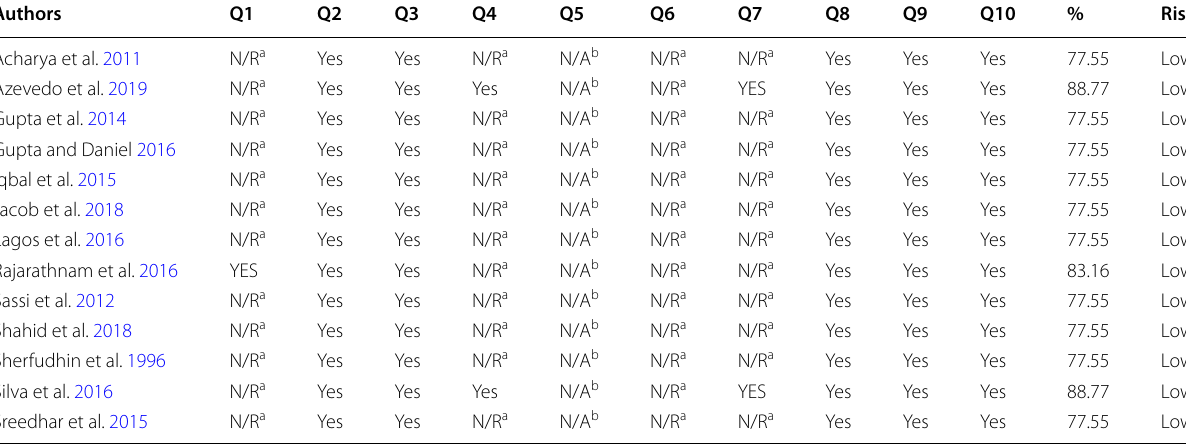
Table 5 Outcomes of the assessment of the risk of bias within eligible accuracy